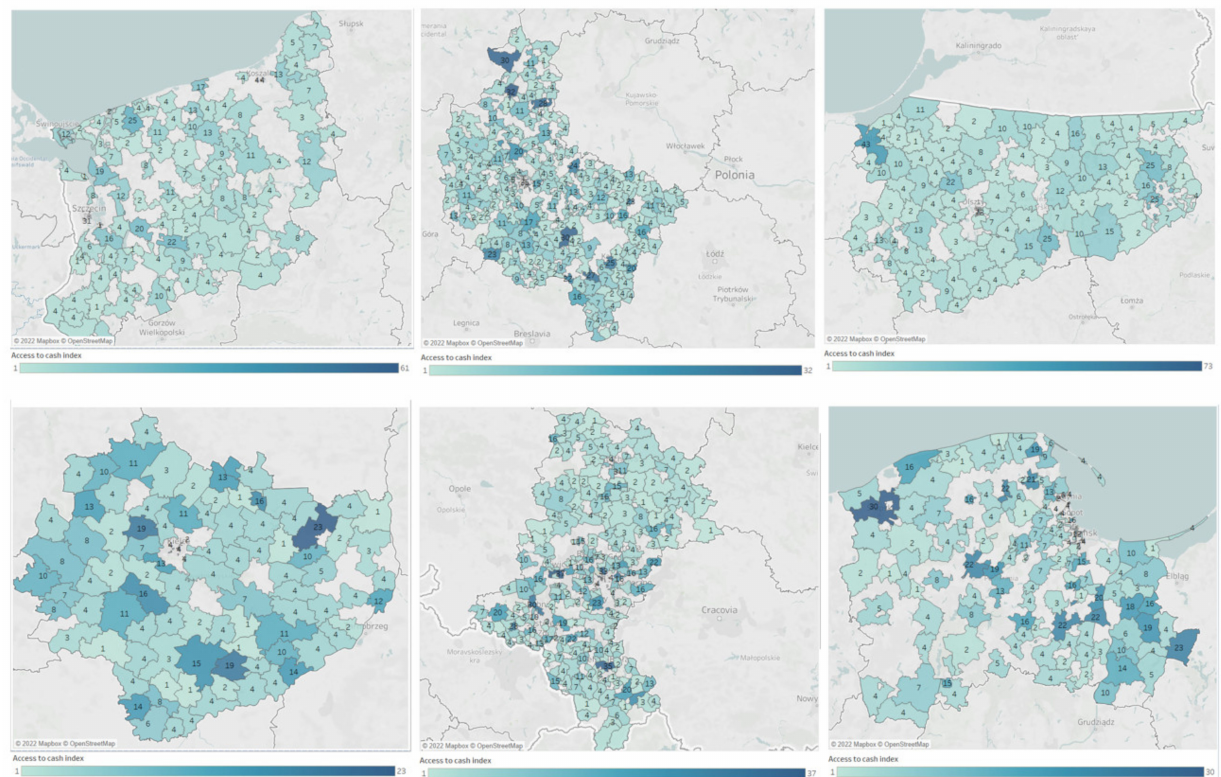
Figure 3. Results of the Access to Cash index in Zachodniopomorskie, Wielkopolskie, Warmi´nsko- Mazurskie, ´Swi˛etokrzyskie, ´Sl ˛askie and Pomorskie voivodeships. Source: Prepared by the authors using Tableau Desktop Professional Edition.